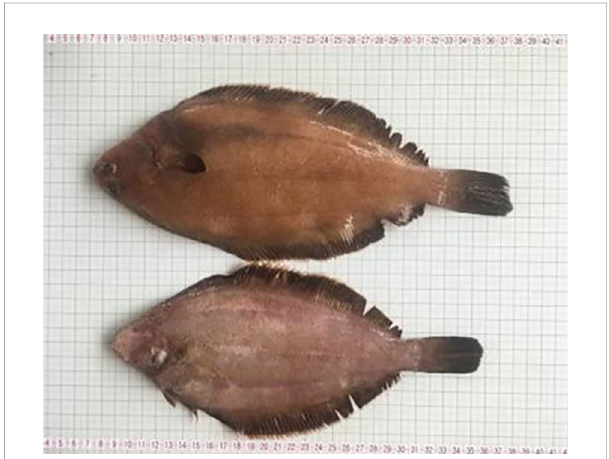
FIGURE 1 Black fi n fl ounder ( Glyptocephalus stelleri , Figure 1) were selected as the target fi sh for this